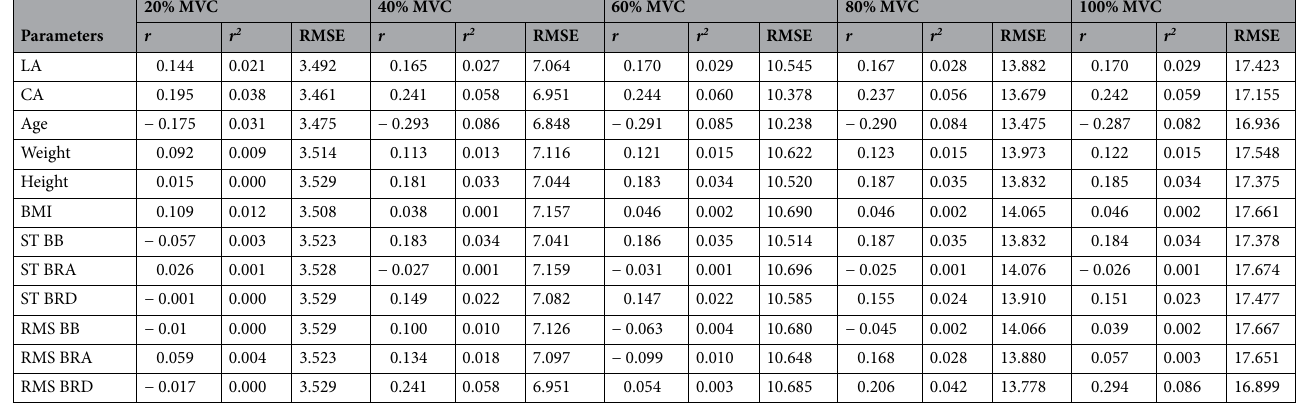
Table 3. Bivariate analysis of torque against anthropometrics and MMG RMS during pronation task. *Bold font indicates significant correlations.